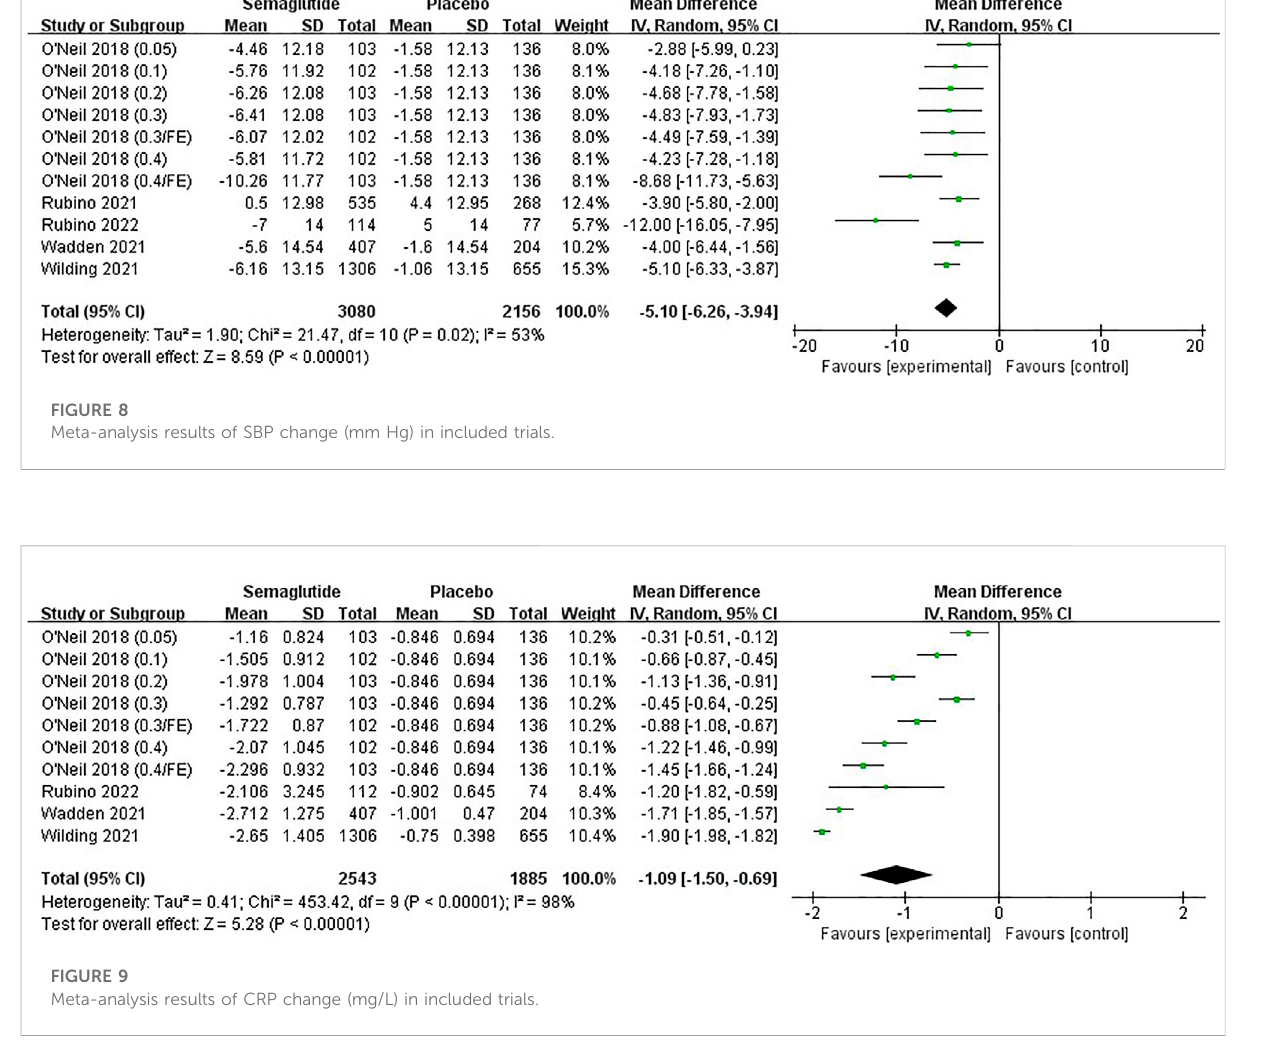
Figure 9 and Supplementary Table S3. Five studies (Wilding